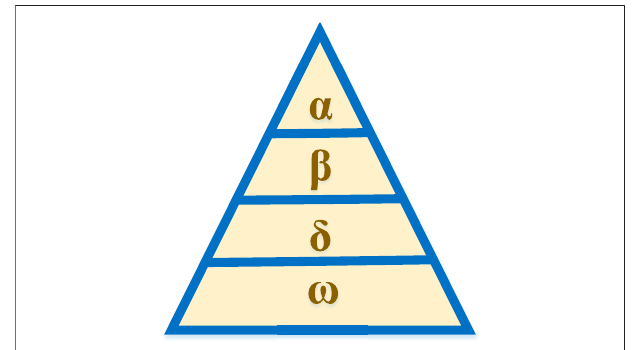
FIGURE 1 | Levels of gray wolves